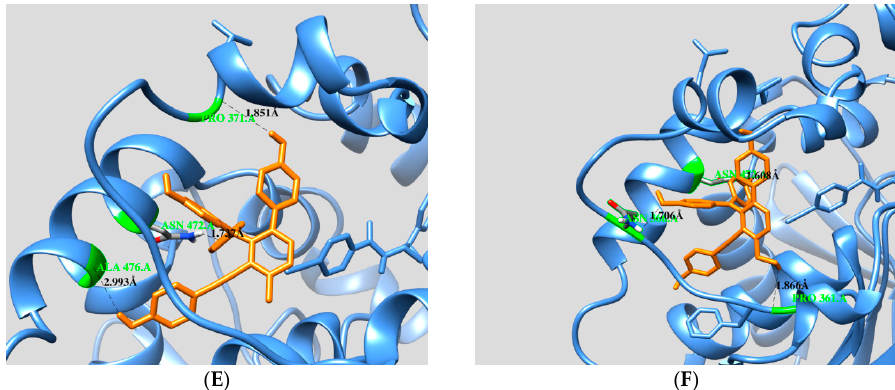
Figure 3. Binding pose at the lowest energy between compounds 1 – 3 and free enzyme ( A – C ), binding pose at the lowest energy between compounds for 1 – 3 and enzyme-substrate complex ( D – F ). Table 2. Docking interactions of inhibitors against sEH.